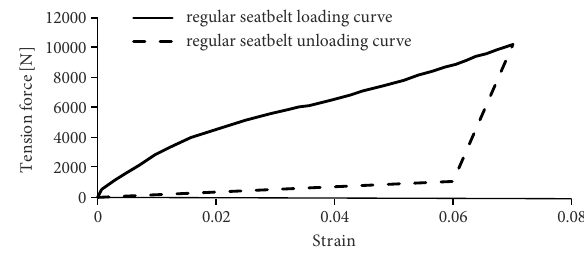
Figure 3. Seatbelt loading and unloading curves